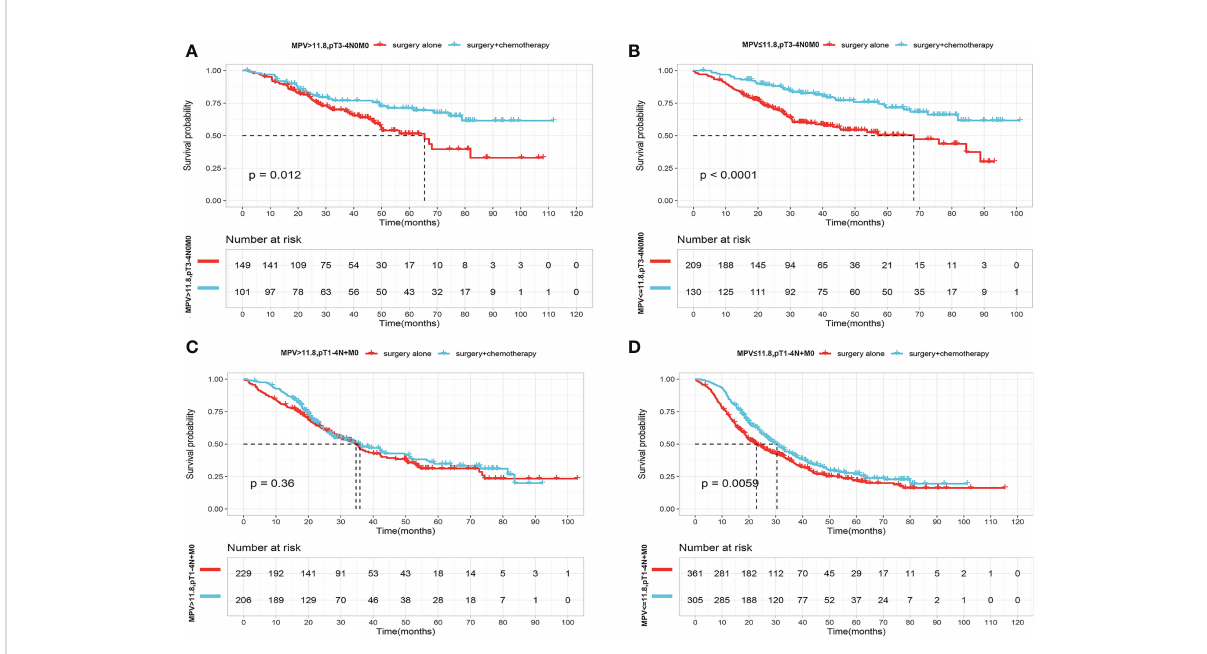
FIGURE 4 (A) OS curves for patients with p T3-4N0M0 stage with S and S+CT of MPV value over 11.8f. (B) OS curves for patients with p T3-4N0M0 stage with S and S+CT of MPV value less than 11.8fL. (C) OS curves for patients with pT1-4N+M0 stage with S and S+CT of MPV value over 11.8fL. (D) OS curves for patients with p T1-4N+M0 stage with S and S+CT of MPV value less than